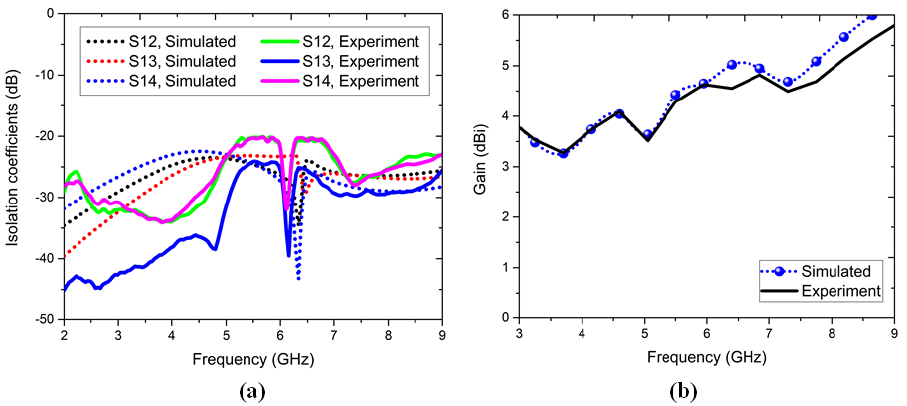
Figure 20. Simulated and experimental results of the ( a ) four-element antenna isolation coefficients and ( b ) four-element antenna gain.